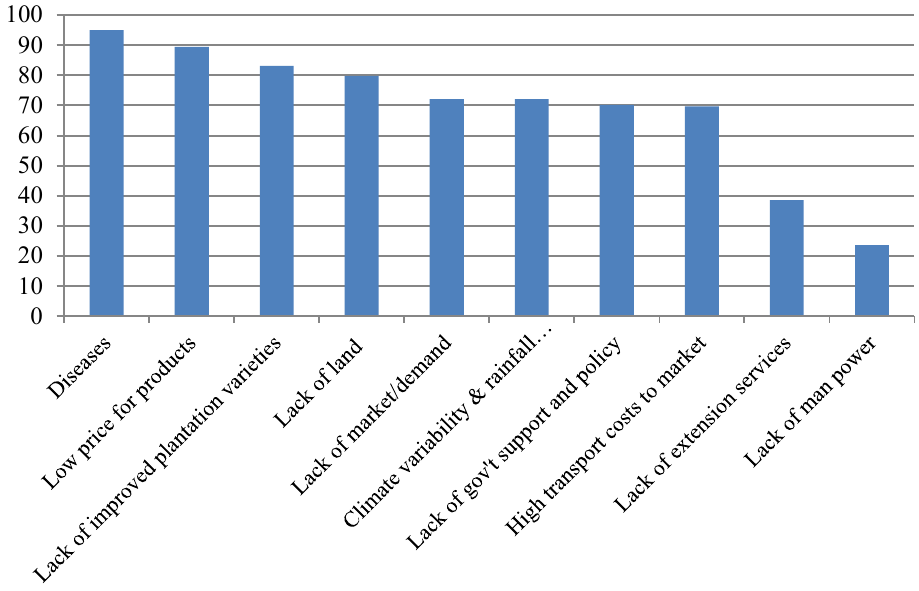
Figure 4. Challenges of small-scale plantations in percent (n =